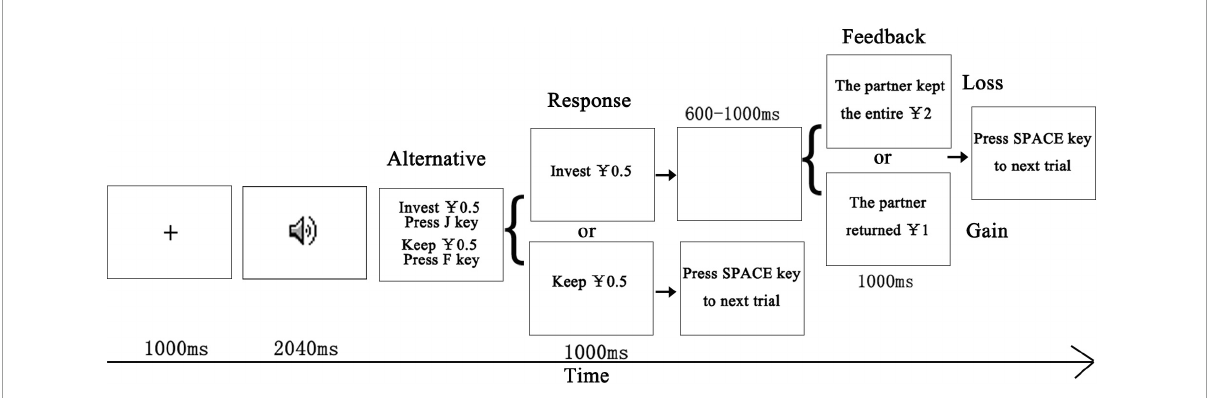
FIGURE1 Trial procedure of the trust game task. A central fixation cross was presented followed by a partner’s voice presented for 2,040 ms. The participant was asked to decide whether to invest (cid:85) 0.5 or refuse to invest (cid:85) 0.5. The decision would be presented for 1,000 ms. If the participant decided to invest, the partner would gain (cid:85) 2. Then, the partner either gave (cid:85) 1 back to the participant or kept the entire (cid:85) 2. If the participant refused to invest (cid:85) 0.5, the amount of money would remain unchanged.